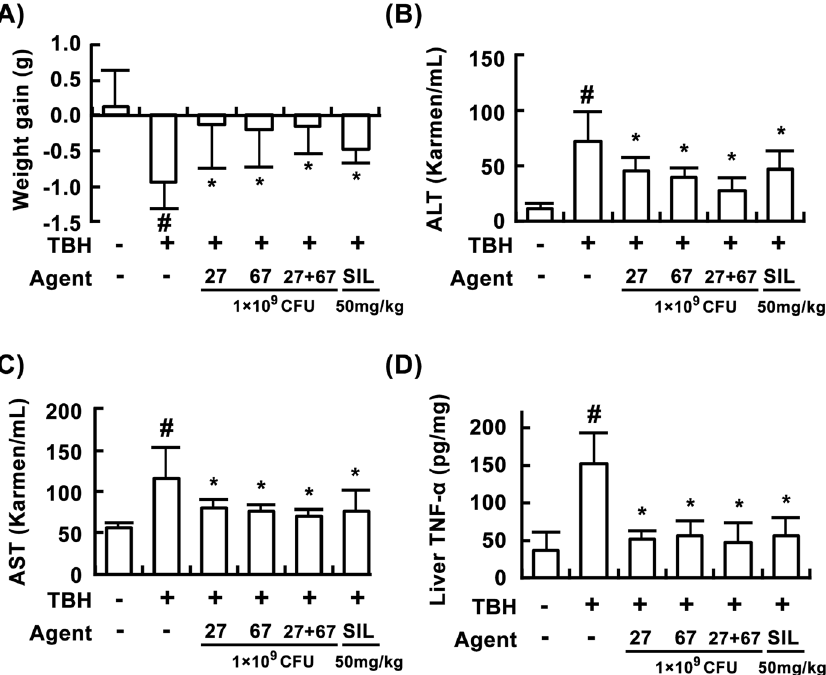
Figure 7. Effects of LC27, LC67, and PM on t -BHP-induced liver injury in mice. Effects on body weight ( A ), blood ALT ( B ), AST ( C ), and liver TNF- α levels ( D ). t -BHP, except in the normal control group, was intraperitoneally injected to mice and test agents [saline, LC27 (2 × 10 9 CFU/mouse), LC67 (2 × 10 9 CFU/ mouse), PM (the mixture of LC27 and LC67 [1:1]; 1 × 10 9 CFU/mouse), or silymarin (SIL, 50 mg/kg)] were orally administered for 3 days. All values are shown as the mean ± SD (n = 6). # p < 0.05 vs. normal control group. * p < 0.05 vs. group treated with TNBS